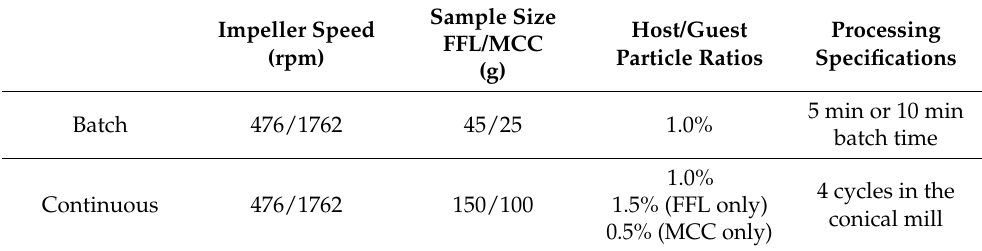
Table 1. Summary of the experimental conditions.